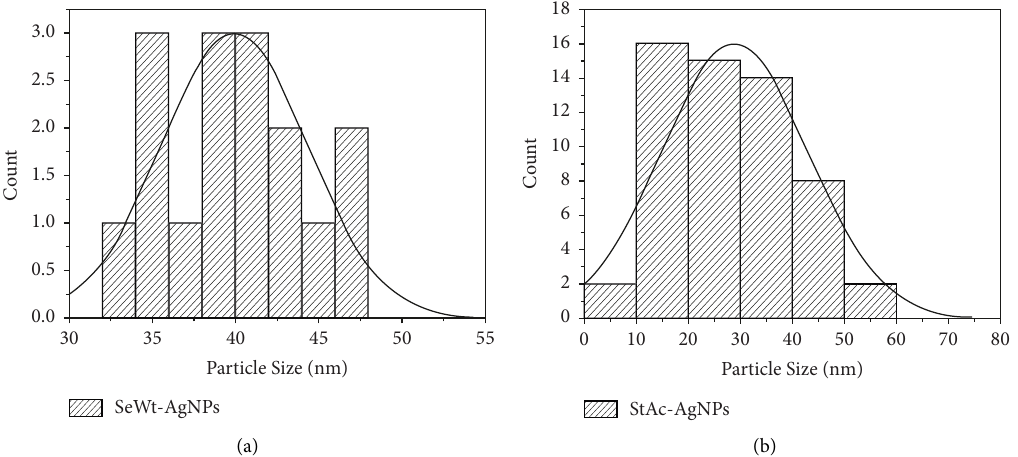
Figure 5: Particle size distributions for (a) AgNPs synthesized from seed extracts of W. tinctoria and (b) AgNPs synthesized from stem extracts of A. catechu .